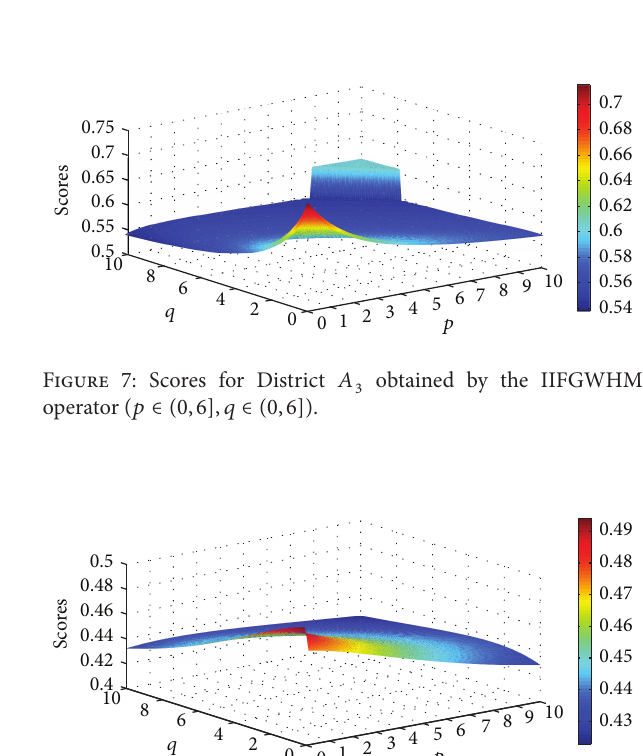
Figure 6: Scores for District 𝐴 2 obtained by the IIFGWHM operator ( 𝑝 ∈ (0,6], 𝑞 ∈ (0, 6] ).